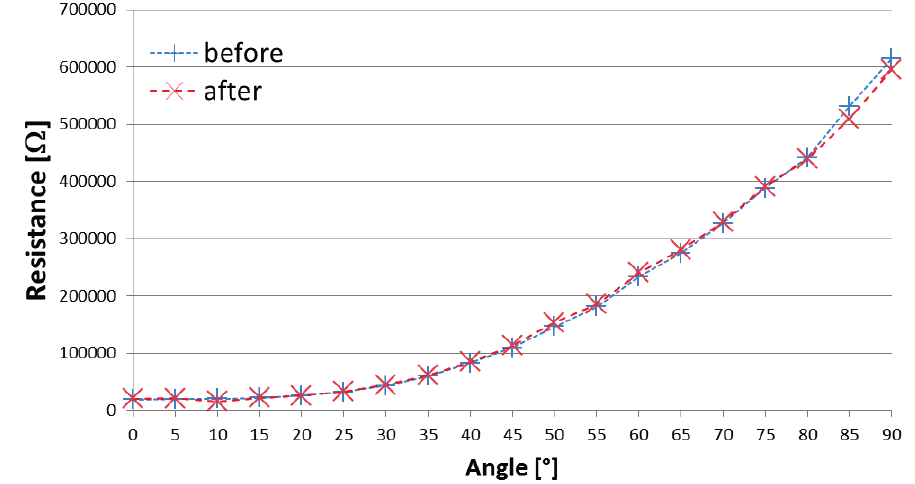
Figure 5. Two resistance vs. bending angle characteristics of one sample of polymide-encapsulated 2” flex sensor. The two curves were recorded before and after the tests. There is no evidence of any degradation of the electrical behavior of the sensor. This plot is for just one sample, but the same kind of behavior was recorded for all the sensors